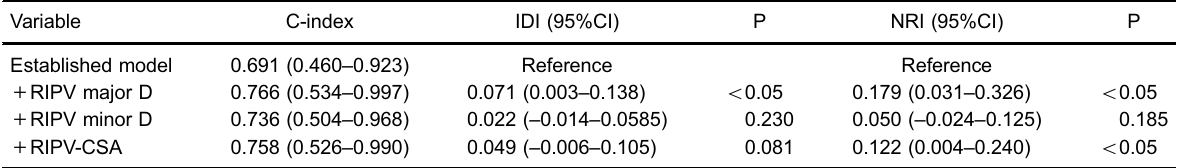
Table 2. Pulmonary vein parameters for the prediction of improvement in integrated discrimination (IDI) and net reclassi fi cation (NRI).